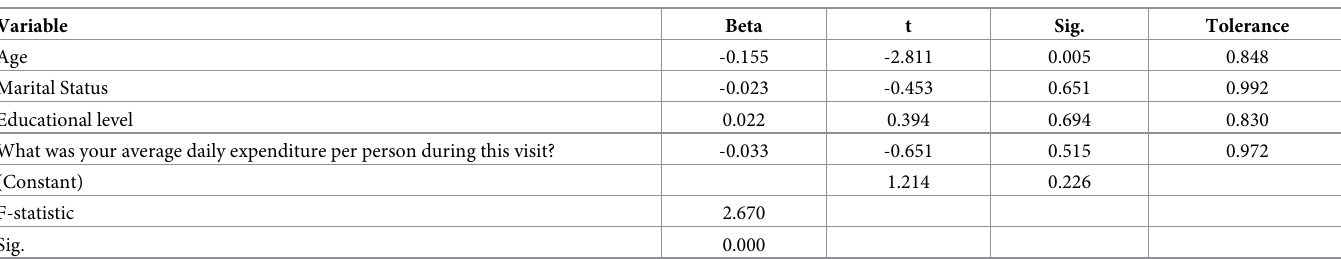
Table 3. Socio-demographic variables and shopping motivation.